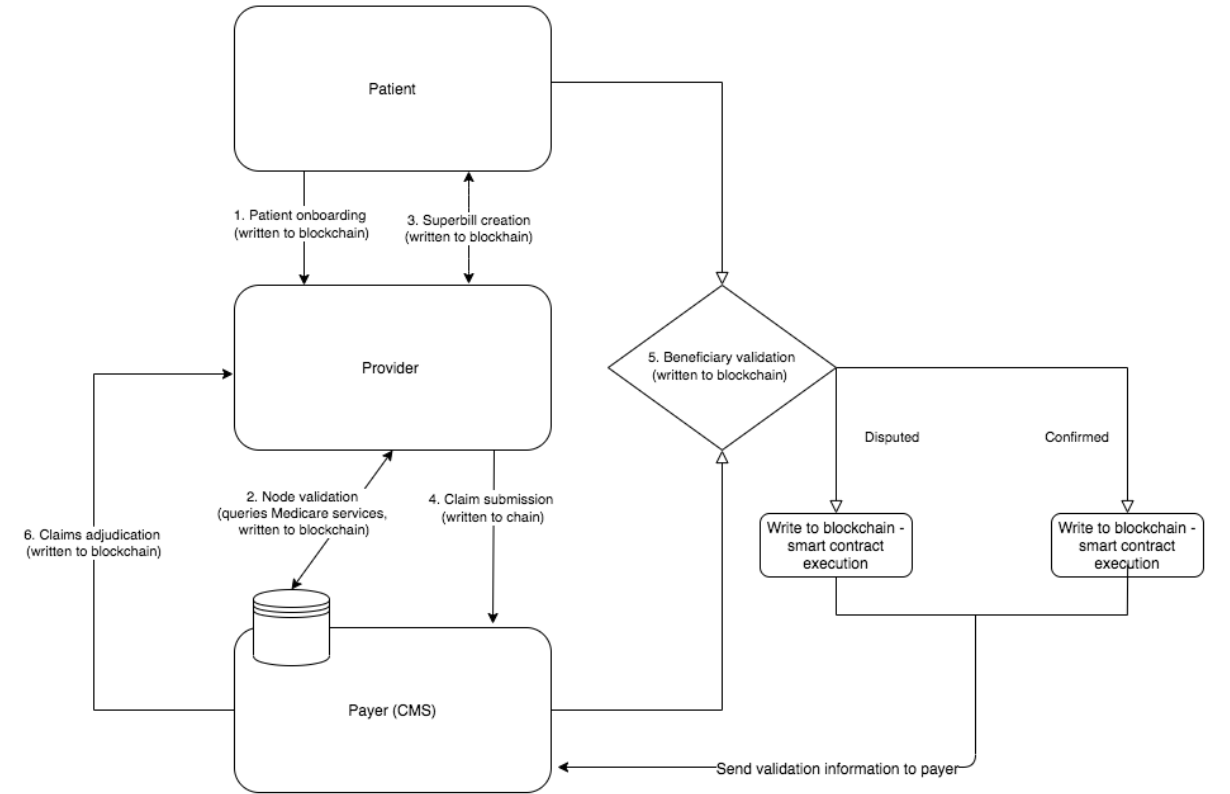
Figure 3. Process for validating data off-chain in proposed framework. CMS: Centers for Medicare and Medicaid